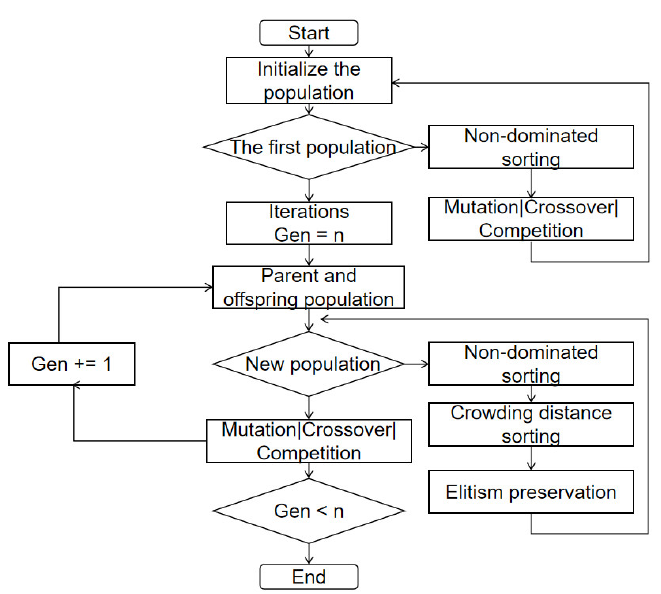
Figure 6. The flow chart of the NSGA-II.